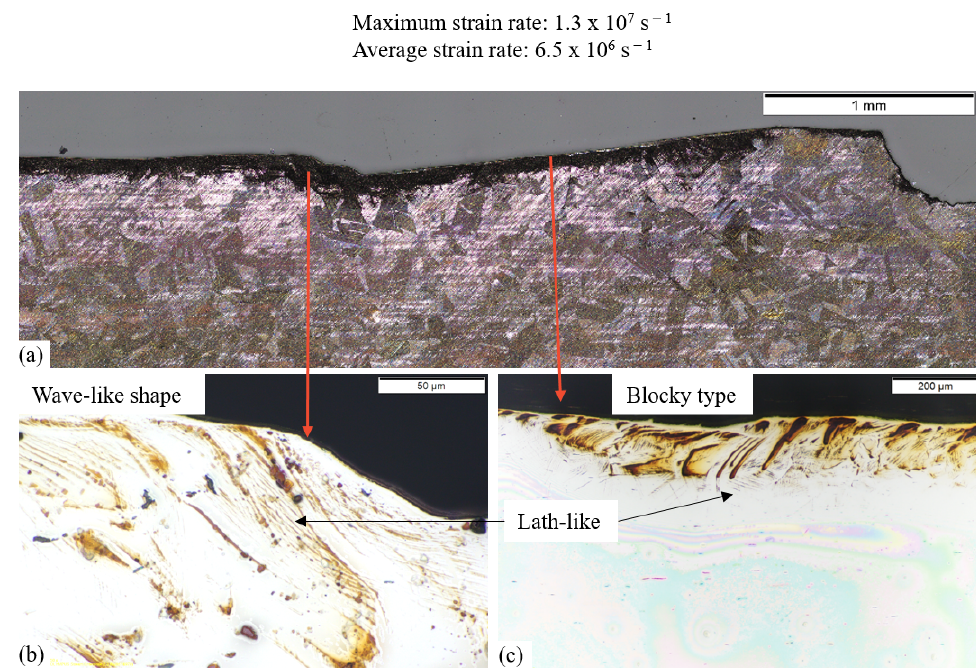
Figure 13. Microstructure analysis of a specimen from a cutting test: ( a ) Beraha II etching, ( b ) magnetic etching, ( c ) blocky martensite in the strongly deformed area directly below the surface and lath-like form at greater depth.